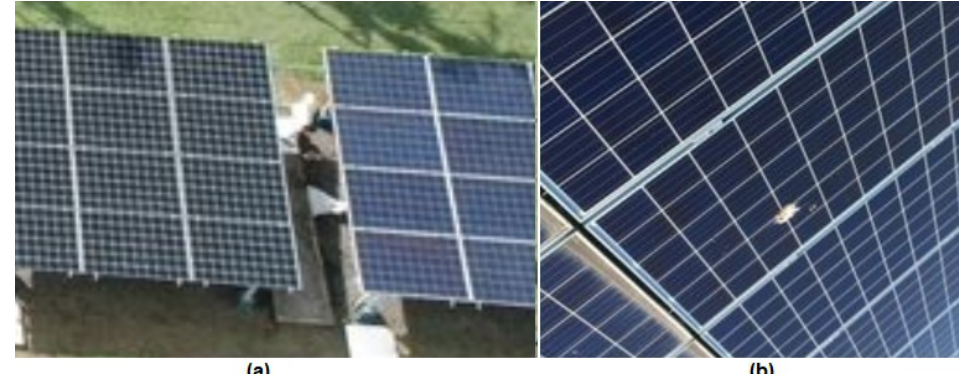
Figure 1. ( a ) PV-chain with partial shade due to a tree, ( b ) PV-chain with dirt due to a bird drop.